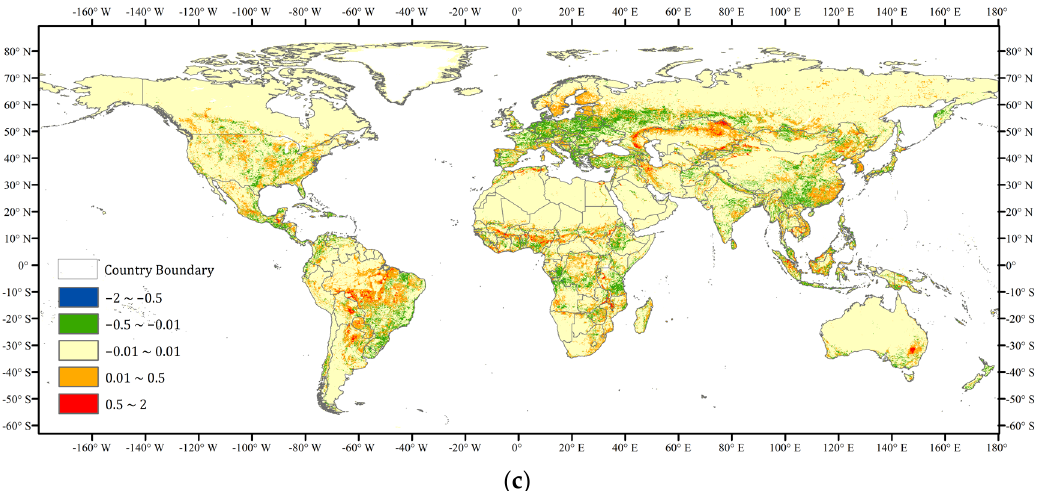
Figure 2. Global LSS distribution and its change. ( a ) LSS distribution in 1992; ( b ) LSS distribution in 2018; and ( c ) difference in the LSS between 2018 and 1992.